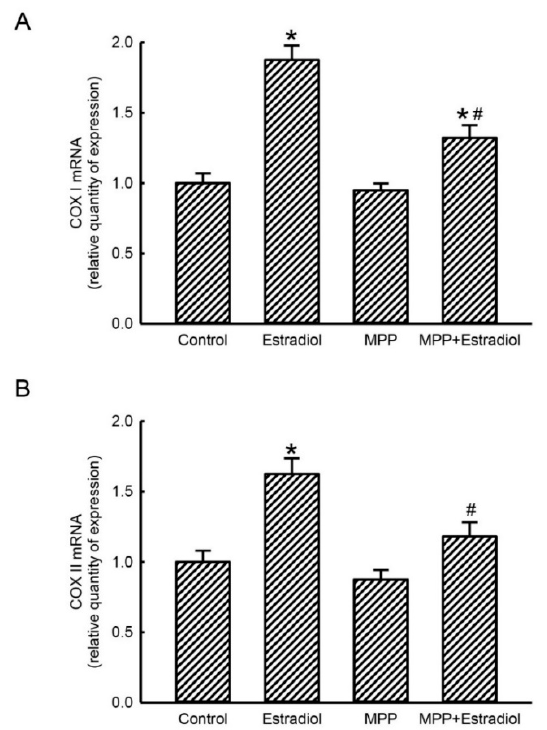
Figure 3. Methylpiperidinopyrazole (MPP) inhibited estradiol-induced expressions of mitochondrial cytochrome c oxidase (COX) I and II mRNAs in rat calvarial osteoblasts. Primary osteoblasts isolated from neonatal rat calvarias were exposed to 10 nM estradiol, 100 µ M MPP, and a combination of MPP and estradiol for 24 h. After drug treatment, total RNAs were prepared from control and drug-treated primary rat osteoblasts. A real-time PCR analysis was further conducted to determine the effects of MPP and estradiol on expressions of mitochondrial COX I mRNA ( A ) and COX II mRNA ( B ). Each value represents the mean ± standard deviation of at least three independent determinations. The symbols * and # indicate that values significantly ( p < 0.05) differed from control and estradiol-treated osteoblasts,